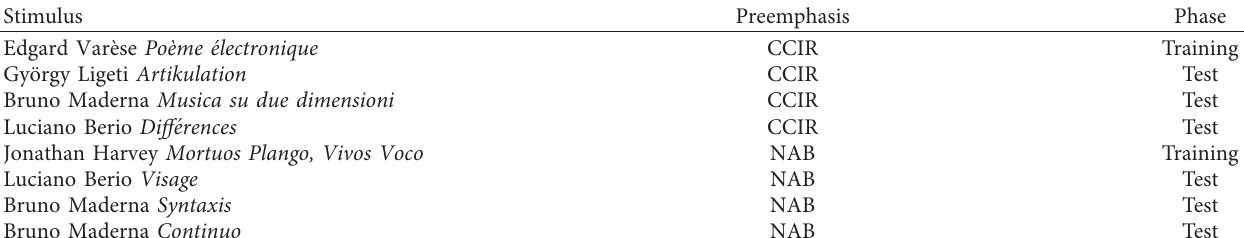
Table 3: The 8 audio stimuli used for the training and test